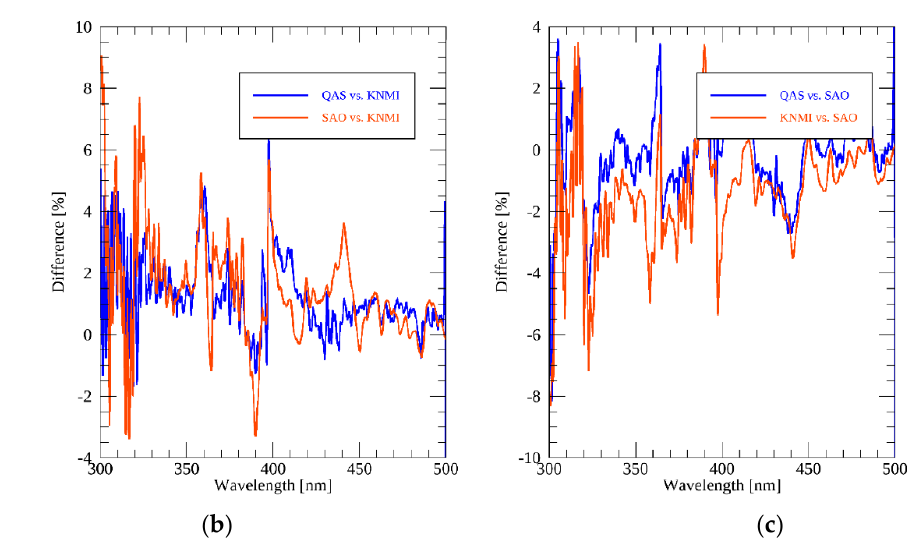
Figure 5. Comparison of high-resolution solar reference spectra at the resolution and spectral range of GEMS. ( a ) High-resolution solar reference spectra used in this study. (SAO2010, KNMI, and QAS respectively). ( b ) The blue line represents the relative percentage difference between the QAS and KNMI spectra, and the orange line shows that between the SAO2010 and KNMI spectra. There is a remarkable difference between SAO2010 and KNMI near 300 nm (up to 8%). ( c ) The blue line represents the relative percentage difference between the QAS and SAO2010 spectra, and the orange line shows that between SAO2010 and KNMI solar irradiances.